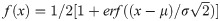
Hiking duration and lenght.Cumulative distribution function of the hiking duration (left) and hiking length (right) in each island. In both panels, solid line represents a fit to a cumulative Gaussian distribution: f(x)=1/2[1+erf((x-μ)/σ2)] with mean μ = 4.6 (10.87) and standard deviation σ = 2.3 (4.57) for the duration (length) distribution in Majorca.